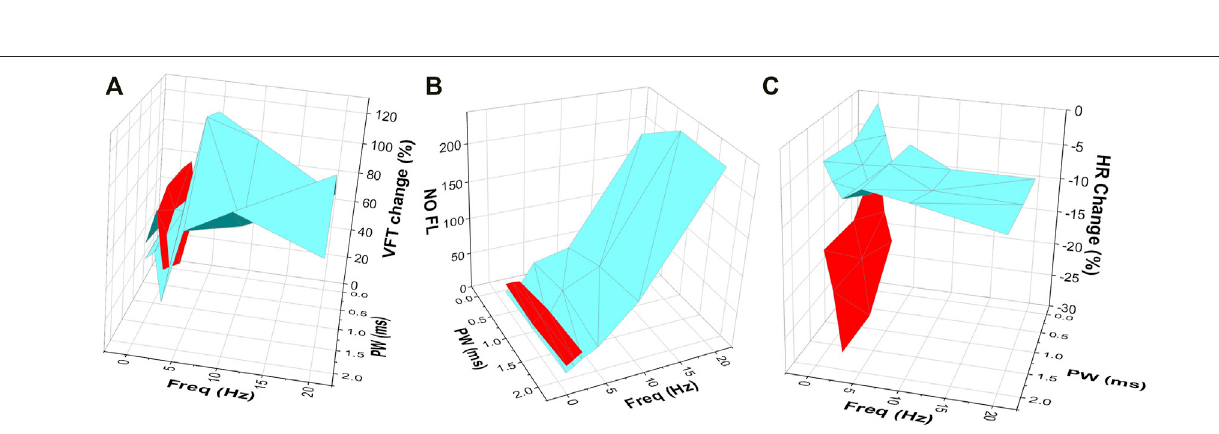
Frontiers in Physiology |